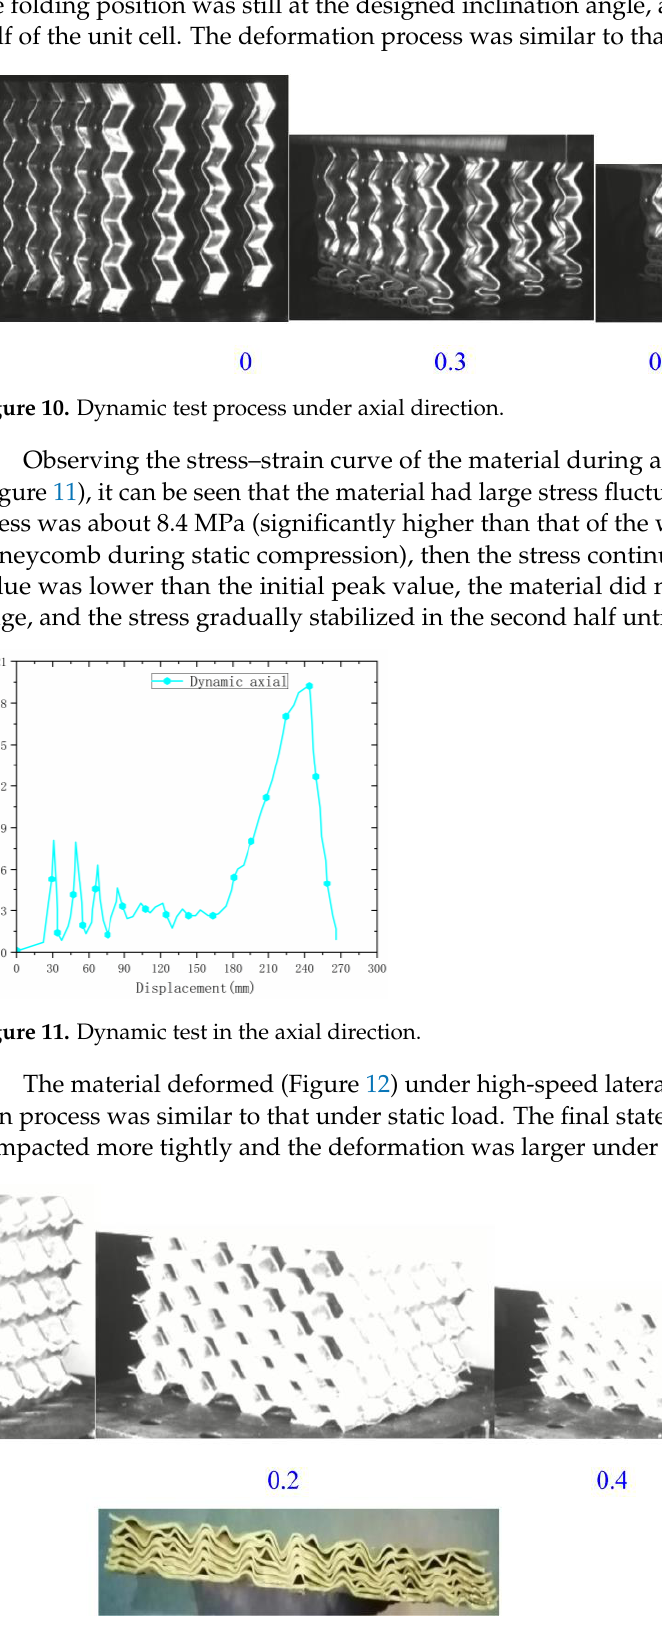
Figure 10. Dynamic test process under axial direction.